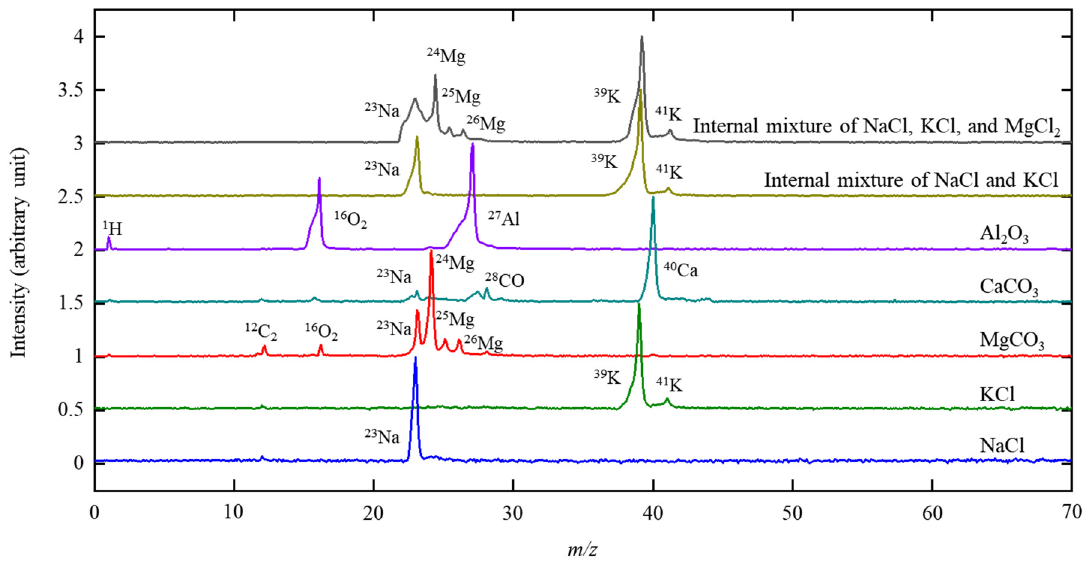
Figure 4. Single-particle mass spectra of NaCl, KCl, MgCO 3 , CaCO 3 , and Al 2 O 3 particles; an internal mixture of NaCl and KCl; and an internal mixture of NaCl, KCl, and MgCl 2 .